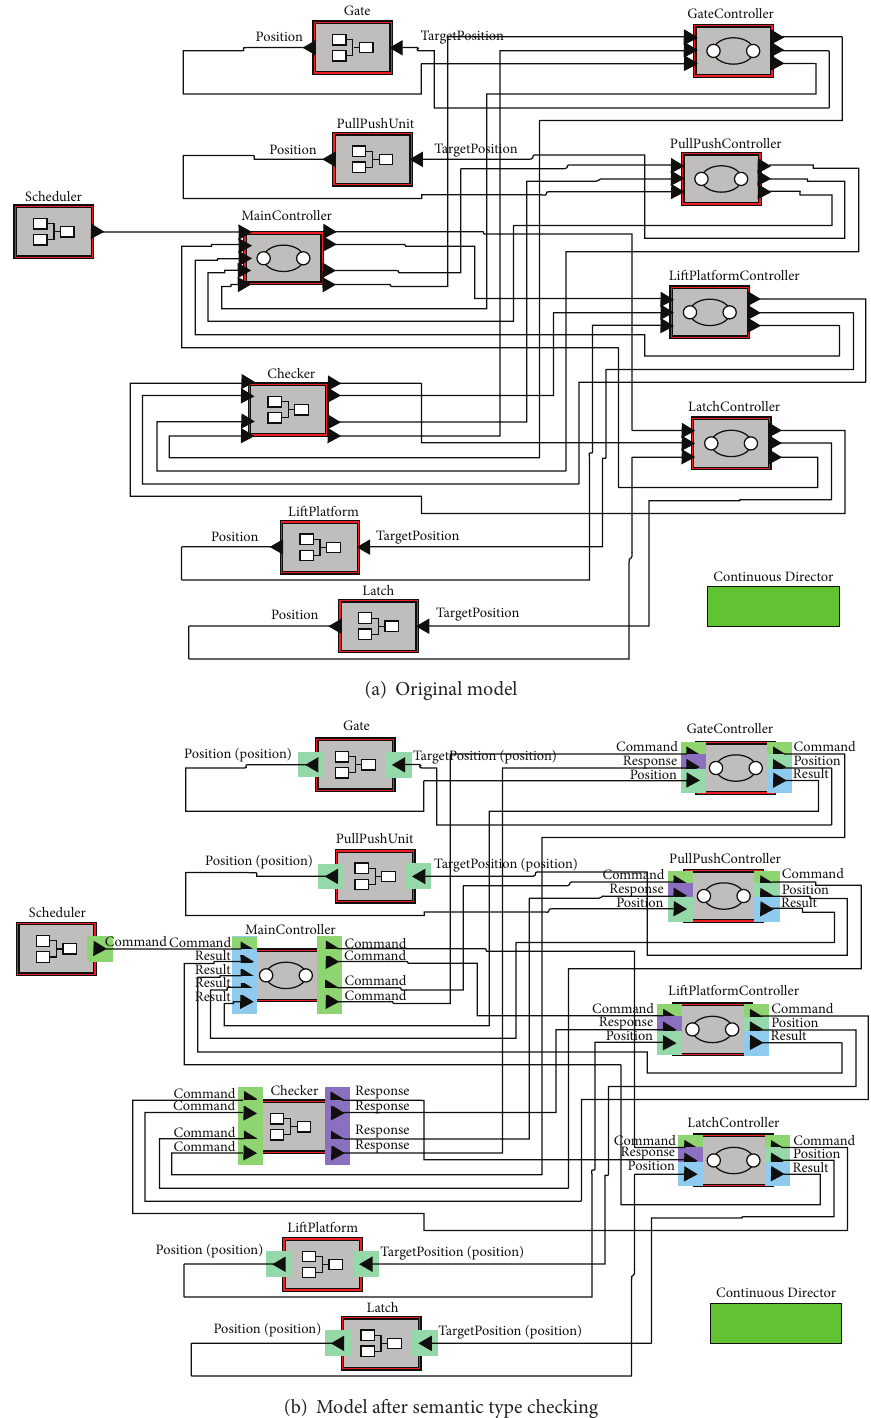
Figure 7: The model of gate control